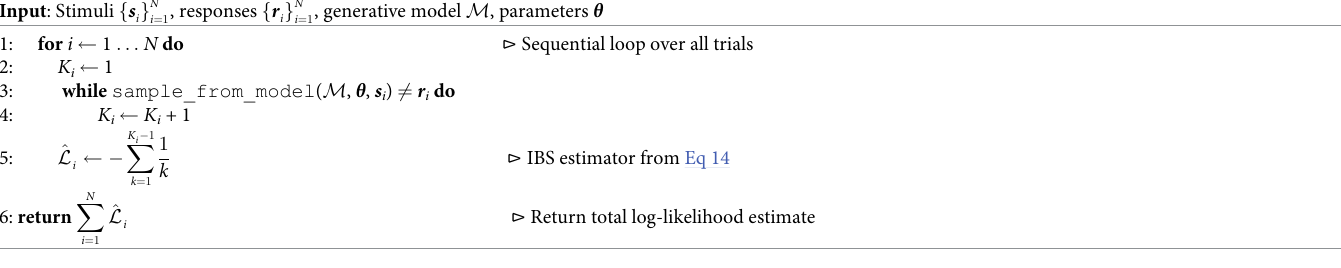
Table 1. Inverse binomial sampling